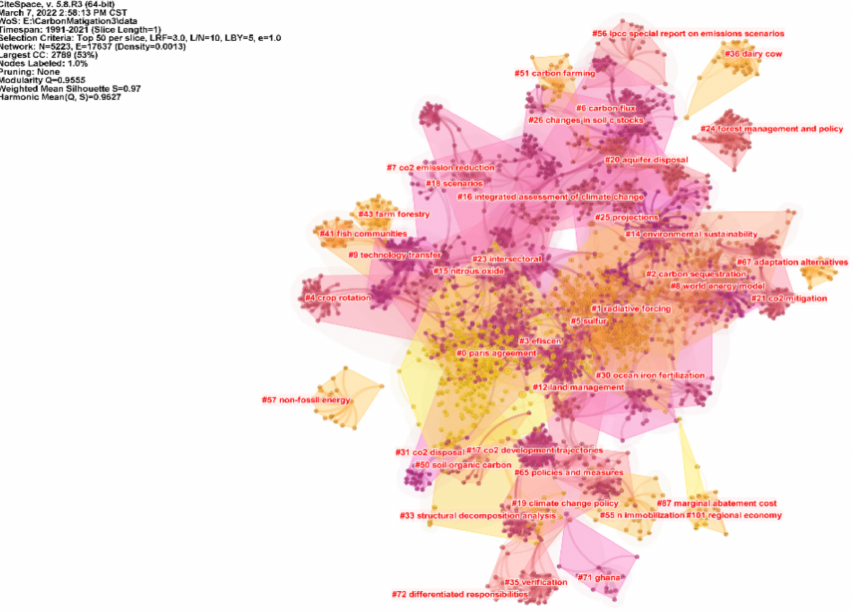
Figure 5. Knowledge Map of Keyword Clustering of Cited Literature in Carbon Emission Reduction Research.